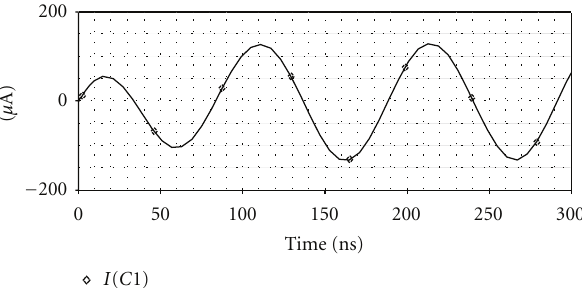
Figure 8: High-pass output for sinusoidal input of 9.7 MHz